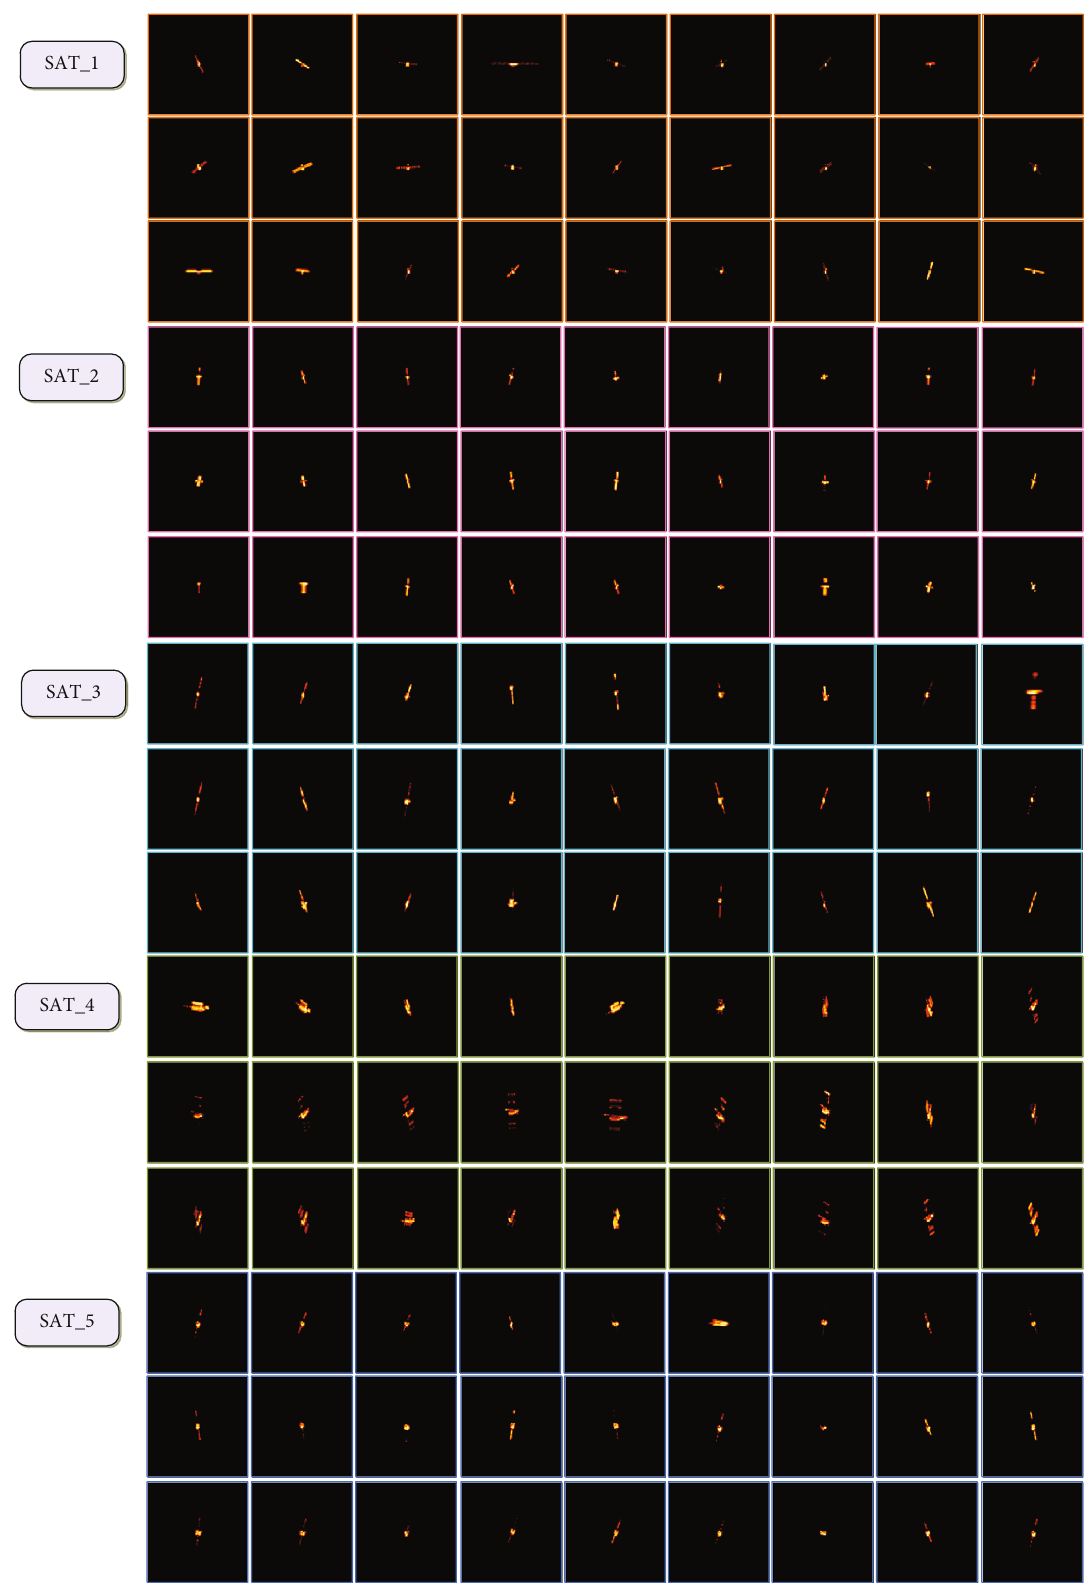
Figure 16: Part of samples in the ISAR image data set of the space